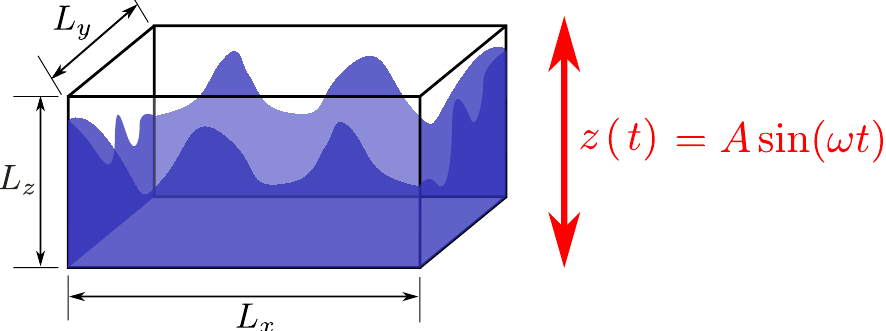
Figure 1. Schematic diagram of oscillating tank setup and